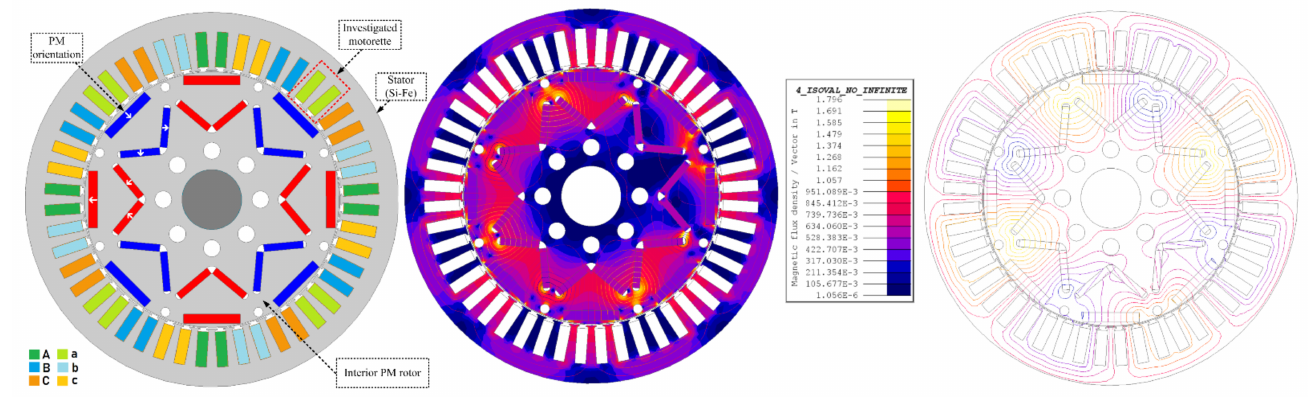
Figure 2. Baseline machine: 110 kW SynRM and winding configuration with FEM analysis at rated power (2019 Nissan Leaf—model